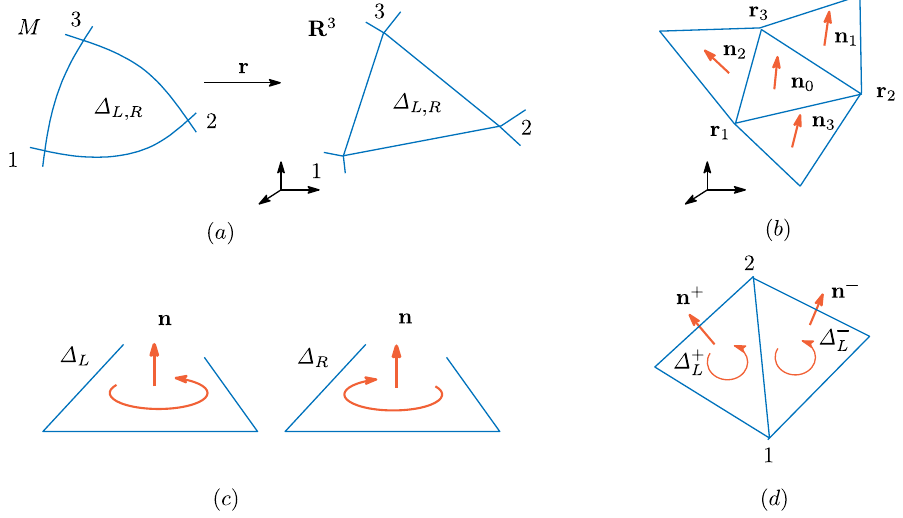
Figure 2. ( a ) A mapping r from a smooth triangle in M to a piecewise linear triangle in R 3 ; ( b ) a triangle and the three neighboring triangles in R 3 ; ( c ) the definition of n on the triangles ∆ L , R ; and ( d ) two neighboring triangles ∆ ± with unit normal vectors n ± and their common bond 12. The suffices of ∆ L , R L denote the orientation of the triangle. The open circles with an arrow at one terminal point indicate the surface